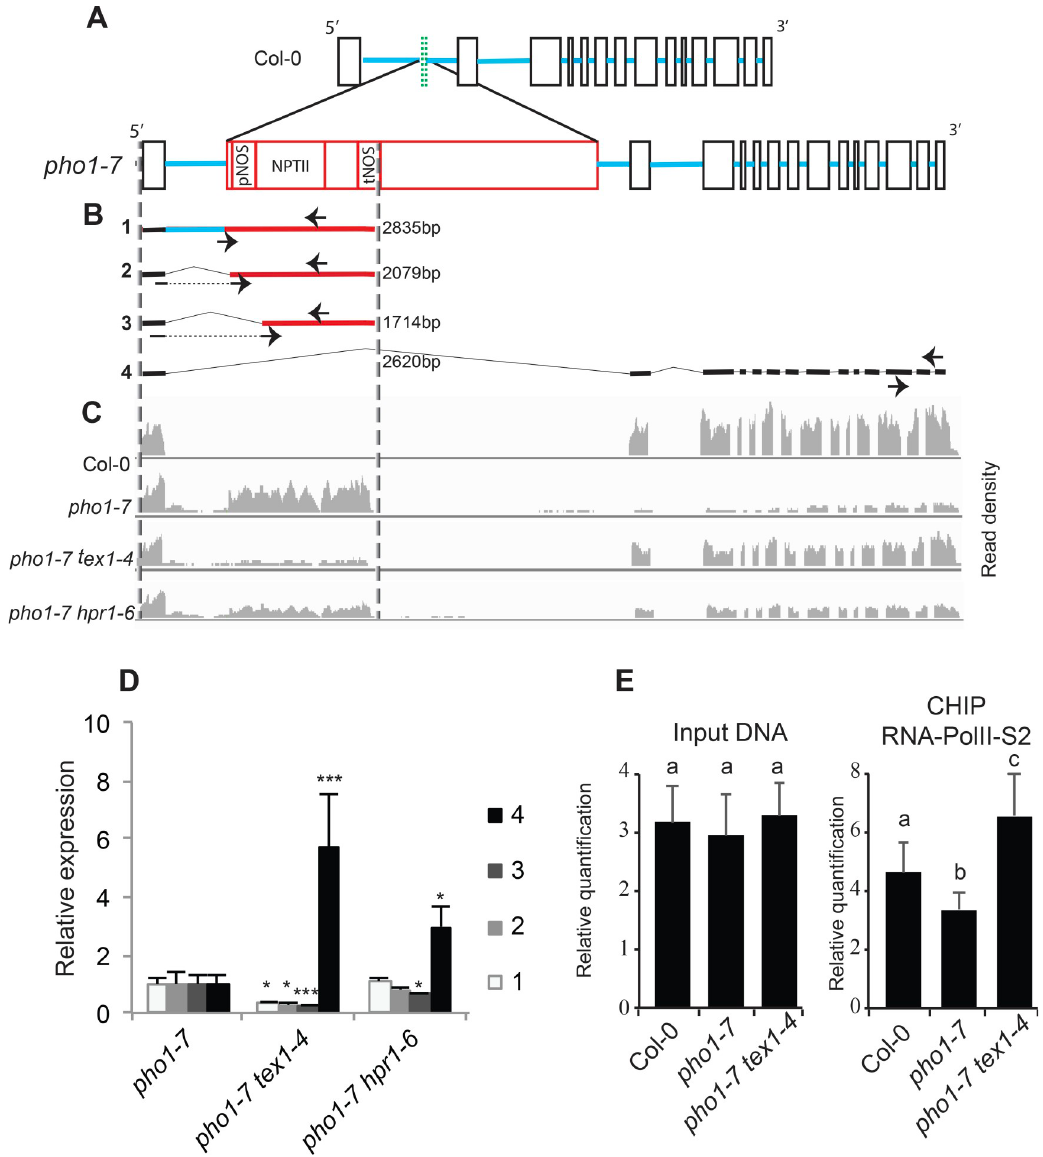
Fig 5. tex1 mutant impairs transcription termination at the NOS terminator. (A) Structure of the wild type PHO1 gene (top) and T-DNA (red) integrated in the pho1-7 mutant (bottom). Exons are indicated as black open boxes, except for the second exon, indicated as a green doted box. Exon 2 is present in Col-0 but deleted in the pho1-7 mutant as a result of T-DNA insertion, which is shown in red. Blue lines represent introns. pNOS, NOS promoter; NPTII, neomycin phosphotransferase gene; tNOS, NOS terminator. (B) Structure of the four mRNA variants produced at the PHO1 locus in pho1-7 mutants. The thick black and blue lines represent sequences derives from PHO1 exons and introns, respectively, while the thick red lines are derived from the T-DNA. The sizes of the different transcripts are shown. Arrows indicate the location of primers used for the qPCR shown in panel D. Forward primers (discontinued arrows) in transcript 2 and 3 are at the junction of cryptic splicing sites to ensure specificity. (C) Illumina RNA sequencing reads density graph showing mRNA expression at the PHO1 locus in various genotypes. The RNA sequencing reads are mapped against the PHO1 locus in pho1-7 , represented in the lower section of panel A (D) Quantification via qPCR of four different mRNA transcripts produced at the PHO1 locus in the roots of 4-week-old plants. The numbers associated with each transcript and primers used for qPCR are shown in panel B. (E) CHIP-qPCR experiments showing the density of RNAPII-S2 at the 3’end of the PHO1 gene. For D and E, data are means of three samples from plants grown in independent pots and three technical replicates for each sample. Error bars represent standard deviation. For D, statistical analysis was performed comparing each PHO1 transcript isoform in pho1-7 tex1-4 and pho1-7 hpr1-6 double mutants relative to the pho1- 7 parent, with asterisks denoting statistical significance ( � , P < 0.05; and ��� , P < 0.001) according to Student’s t test. For E, values marked with lowercase letters are statistically significantly different from those for other groups marked with different letters (P < 0.05, ANOVA with the Tukey-Kramer HSD